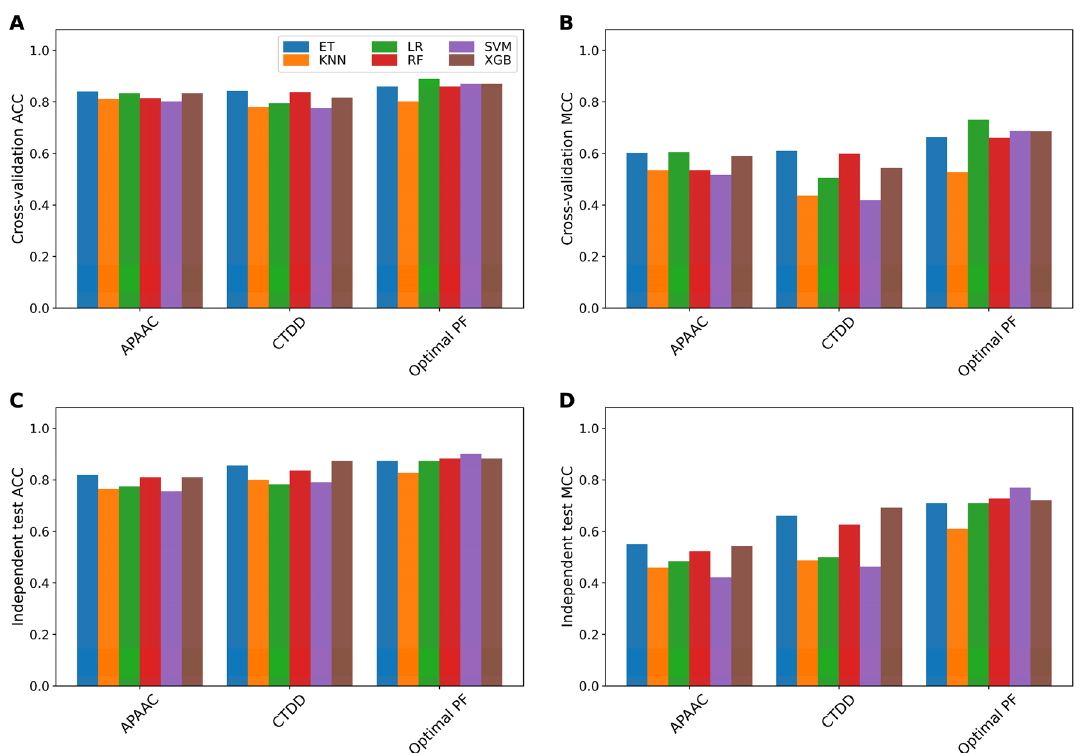
Figure 3. Performance comparison of optimal PF and conventional feature descriptors for six ML algorithms (ET, KNN, LR, RF, SVM and XGB) in terms of cross-validation ACC and MCC ( A , B ) and independent test ACC and MCC ( C , D